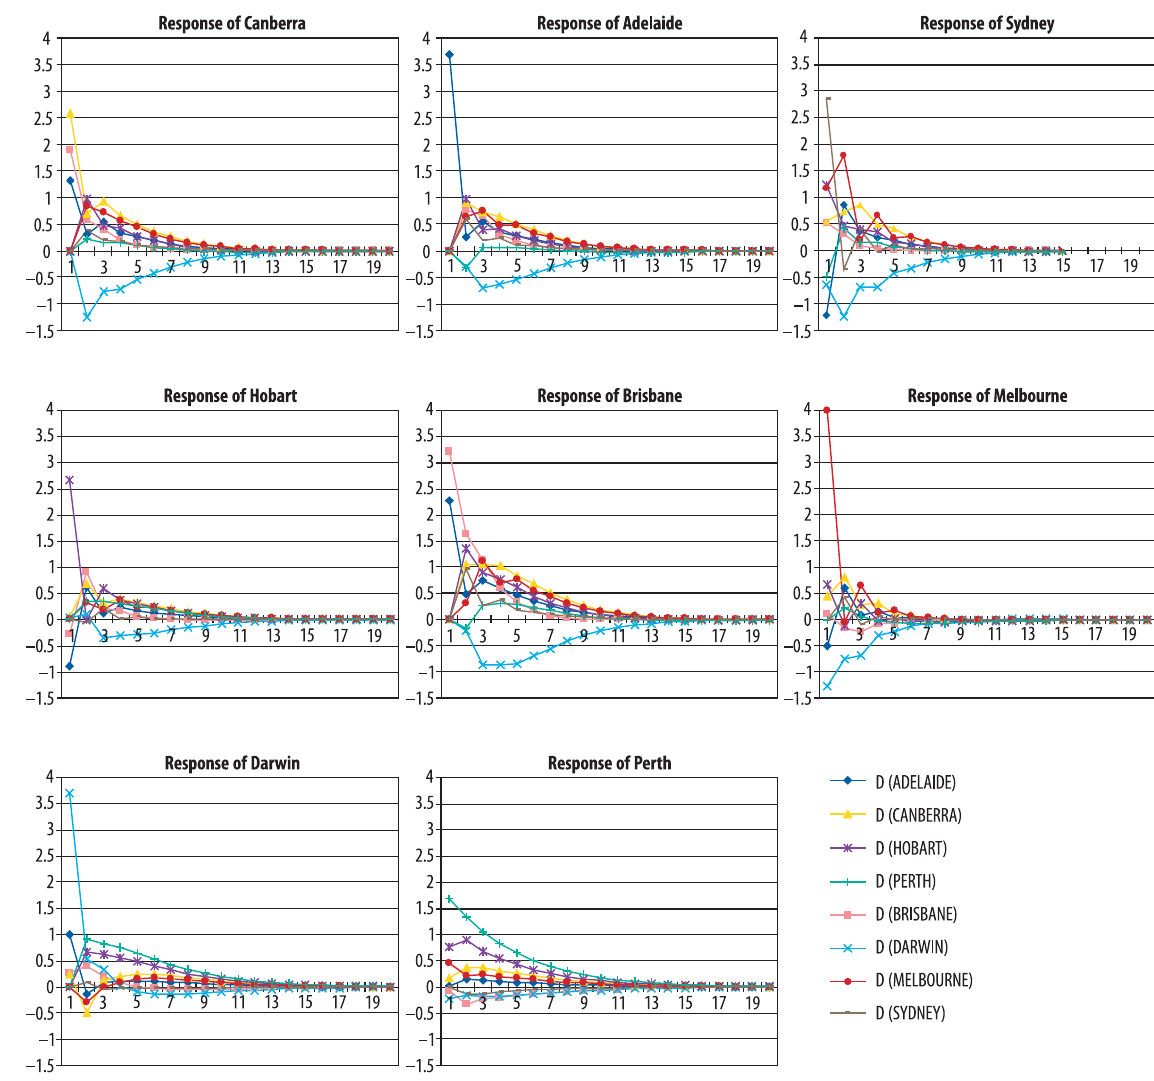
Figure 2. Impulse response of one housing market to shocks from other